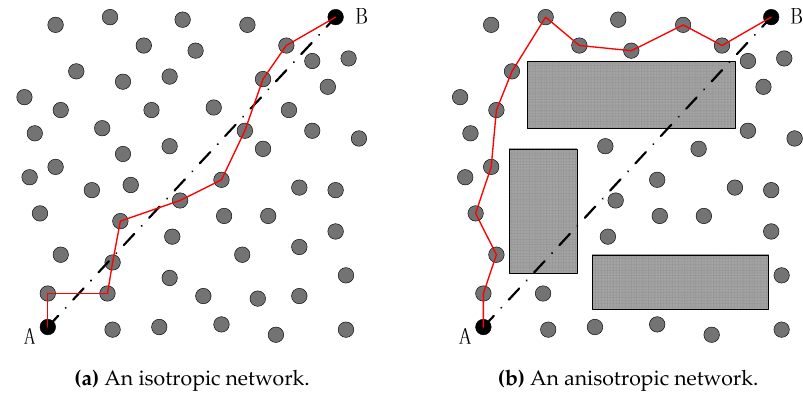
Figure 1. An example of network anisotropy’s impact on the hop distance.